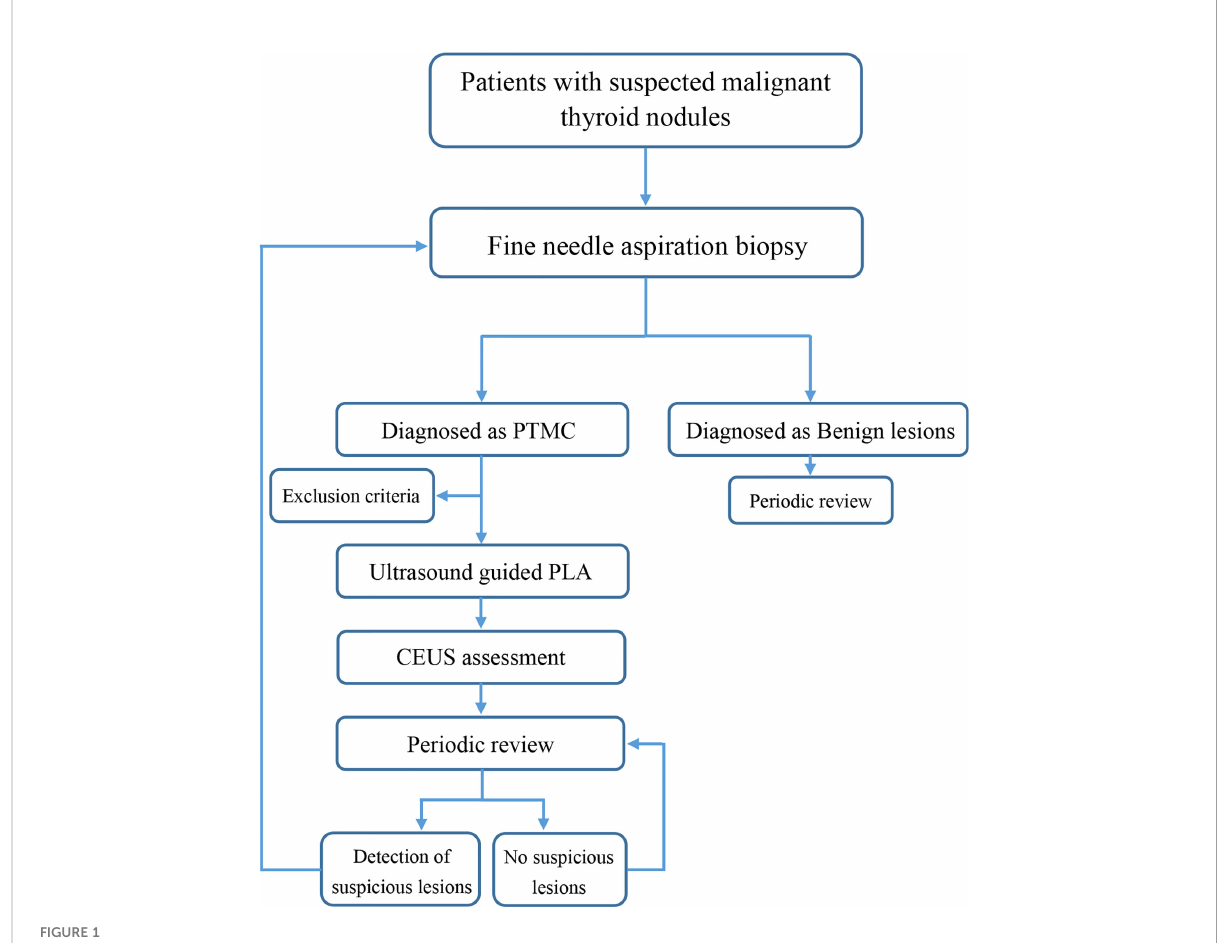
FIGURE 1 Study fl